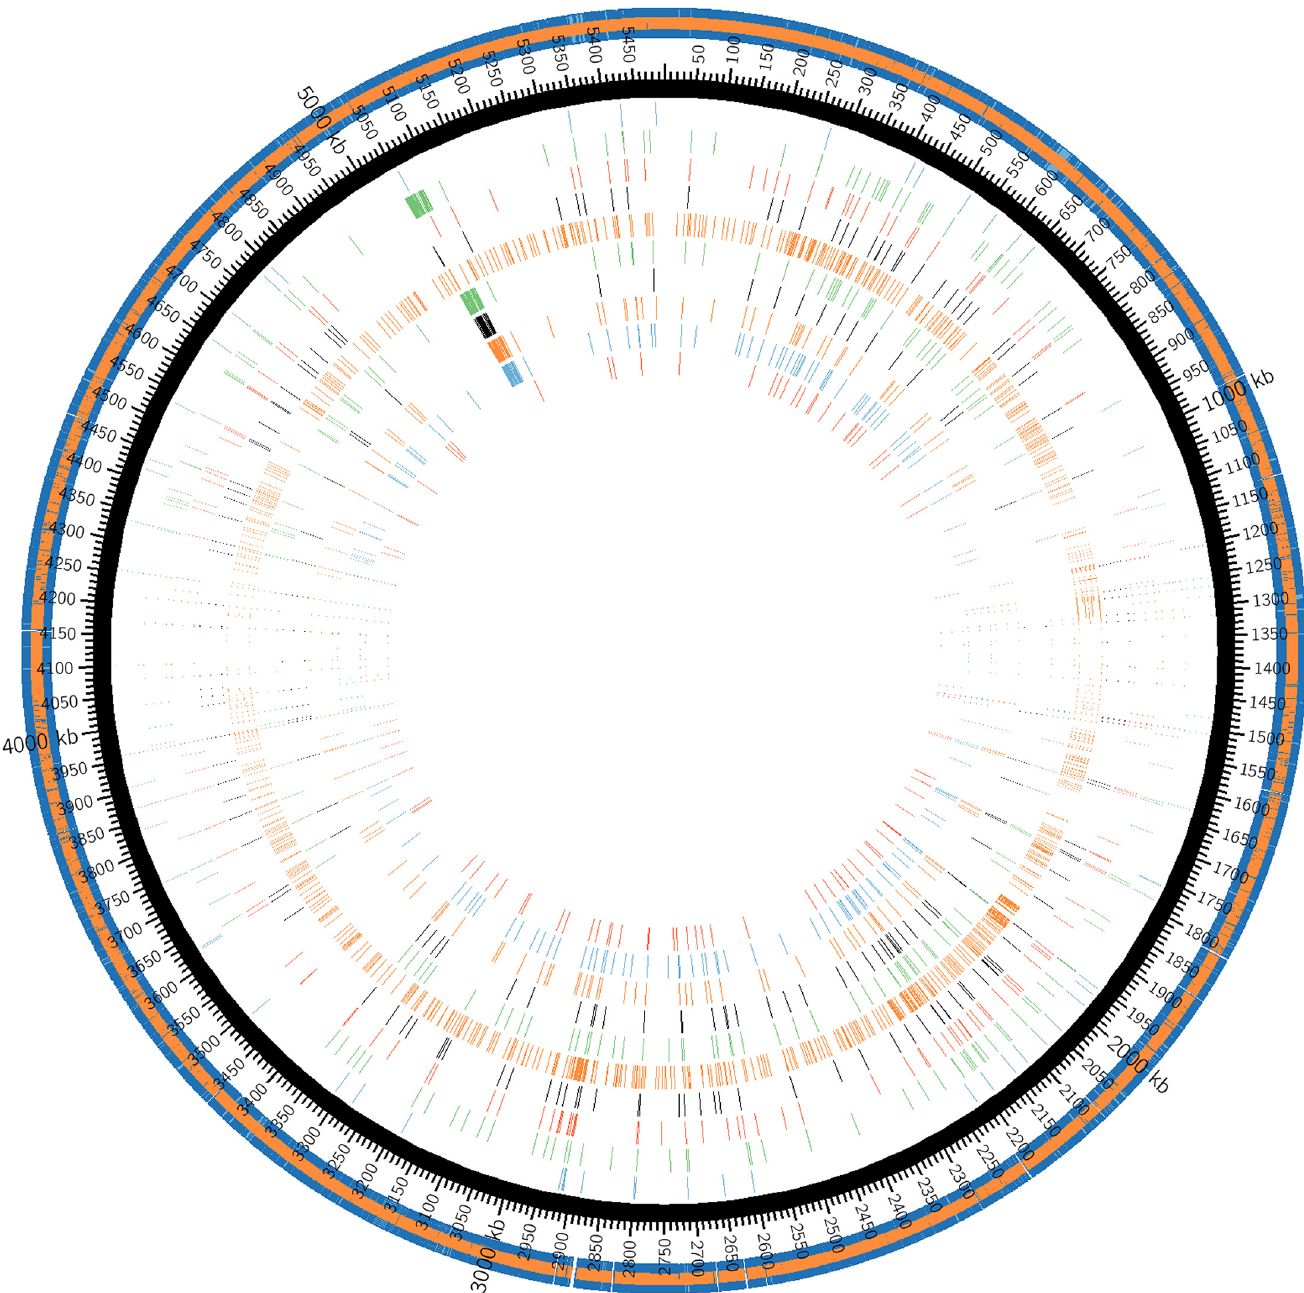
Fig 2. Single nucleotide polymorphisms observed within selected isolates (n = 10) as compared to references stain E . coli O157:H7 Sakai (outer ring). Isolates starting from inner circle are: K9_107F (4.33 log CFU/g), 219_Jul8 (NSS), H7_224F (8.26 log CFU/g), 274_Jul8 (8.00 log CFU/g), 299_Jul8 (NSS), 342_Jul28 (NSS), K3_66F (4.86 log CFU/g), K9_16F (5.13 log CFU/g), 287_Jul8 (NSS), and K9_45F (8.45 log CFU/g). Intensity of bands depicts frequency of